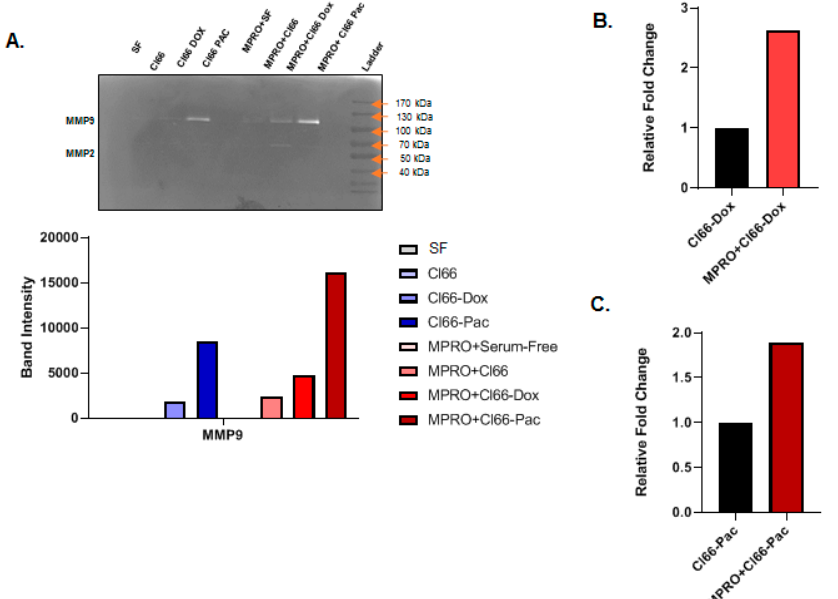
Figure 6. Neutrophils cultured in the supernatant of chemotherapy-resistant cell lines Cl66-Dox, and Cl66-Pac secreted higher matrix metallopeptidase-9 (MMP9). ( A ) Representative image of zymography and a bar graph showing MPRO cells cultured in the supernatant of the chemotherapy-resistant cell lines-Cl66-Dox and Cl66-Pac secreted higher MMP9 and matrix metallopeptidase-2 (MMP2). ( B , C ) Bar graph showing relative fold increase in the secretion of MMP9 by MPRO in culture with Cl66-Dox ( B ) and Cl66-Pac ( C ) in comparison with the supernatant alone of the Cl66-Dox and Cl66-Pac cell lines, respectively. The image was quantified using ImageJ software. The data are representative of two independent experiments with similar results.